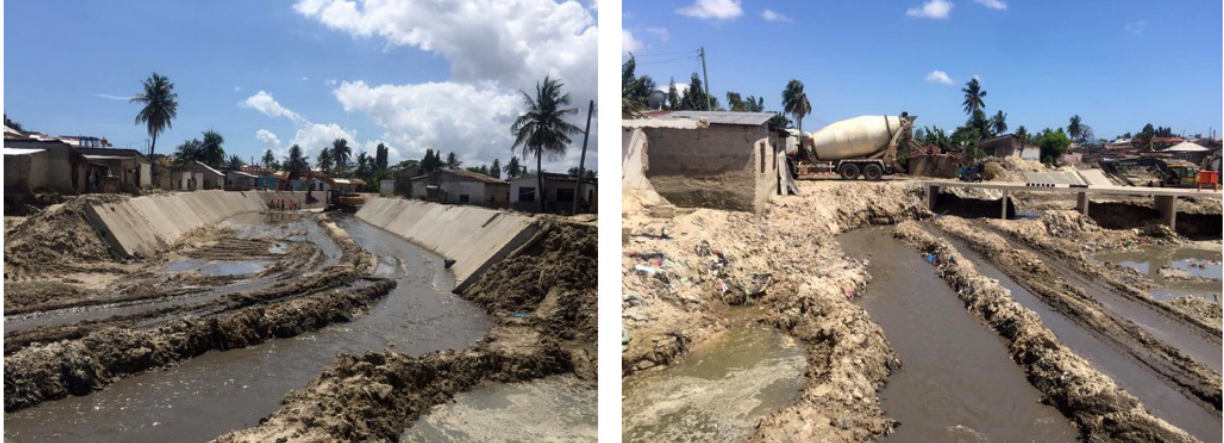
Figure 12. Large‐scale infrastructure work at the Ng’ombe River. Source: Courtesy of Beatrice Mahagama and Leticia